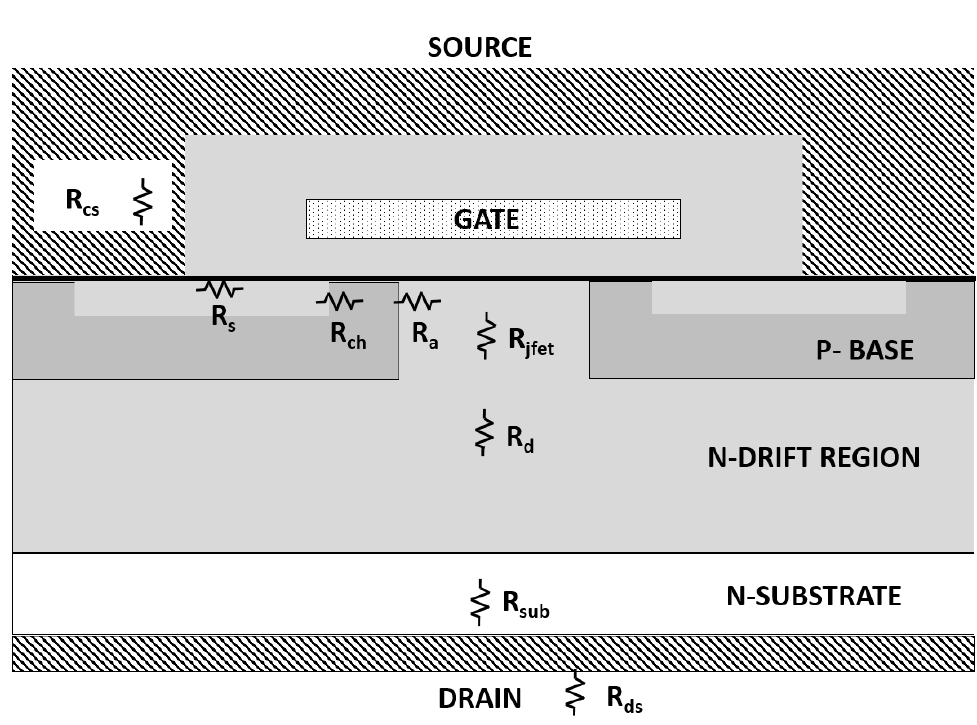
Figure 6. Power vertical diffused MOSFET structure with its internal resistances.